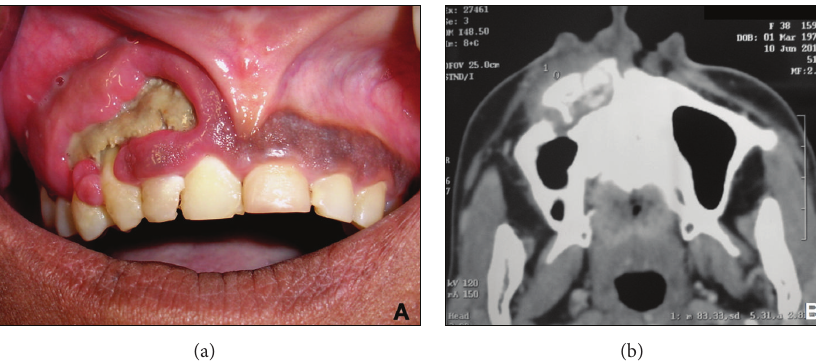
Figure 1: Clinical (a) and radiographic (b) image upon presentation. (a) Note the exposed bony sequestrum and significant destruction of gingiva and alveolar mucosa in the maxillary right quadrant. (b) Axial view (CT scan); note the alveolar bone destruction on the maxillary right quadrant, the surrounding radiolucent halo, and the partial destruction of the front wall of the right maxillary sinus.